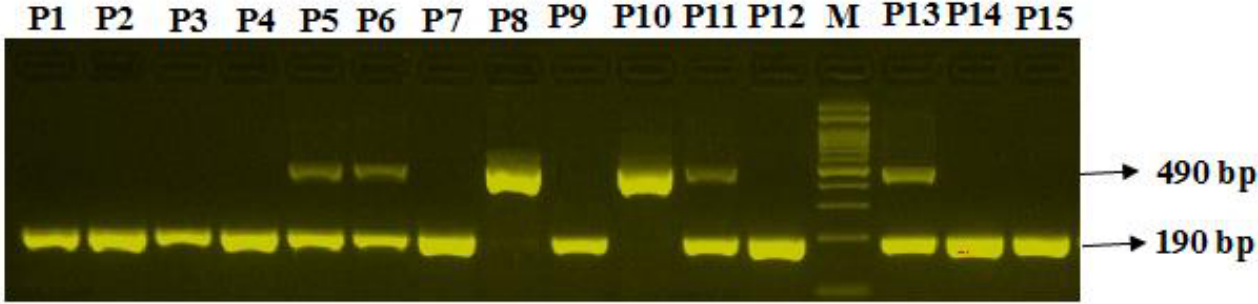
Figure 1. Optimization of Angiotensin-Converting Enzyme 2 genotyping ACE2-rs4646994 D/I in coronary artery disease patients. Legend: M-100 bp DNA ladder; Heterozygous D/I-P5,P6,P11,P13; Homozygous II-P8,P10; Homozygous DD-P1,P2,P3,P4,P7,P9,P12,P14 & P15.